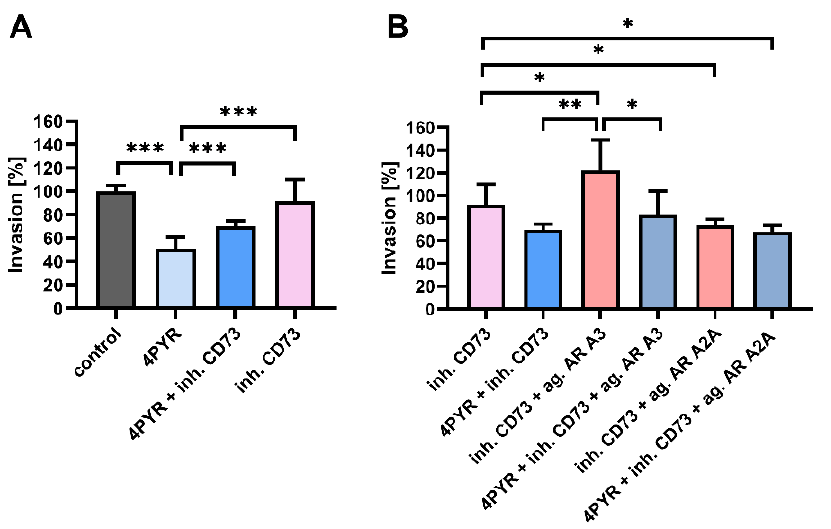
Figure 3. The effect of 4PYR on the invasive potential of 4T1 cells is blocked by CD73 inhibition and mediated through adenosine receptors (AR). ( A ) Transwell invasion assay of 4T1 cells treated with 4PYR (100 µ M), CD73 inhibitor, AOPCP (200 µ M; inh. CD73), or their combination, relative to vehicle- treated control. ( B ) Transwell invasion assay of 4T1 cells treated with 4PYR (100 µ M), specific AR agonists (ag. AR A3, IB-MECA for A 3 AR; ag. AR A2A, CGS-21680 for A 2A AR; 10 µ M of each agonist), or their combination in the presence of CD73 inhibitor (to inhibit endogenous eAdo generation), relative to vehicle-treated control (100%; the bar is not shown). Cells that invaded through Matrigel in the Transwell invasion chamber after 24 h were stained with Mayer’s Hematoxylin and counted under the microscope. The graph represents the mean ± SEM from three independent experiments. * p < 0.05, ** p < 0.01, *** p < 0.001.